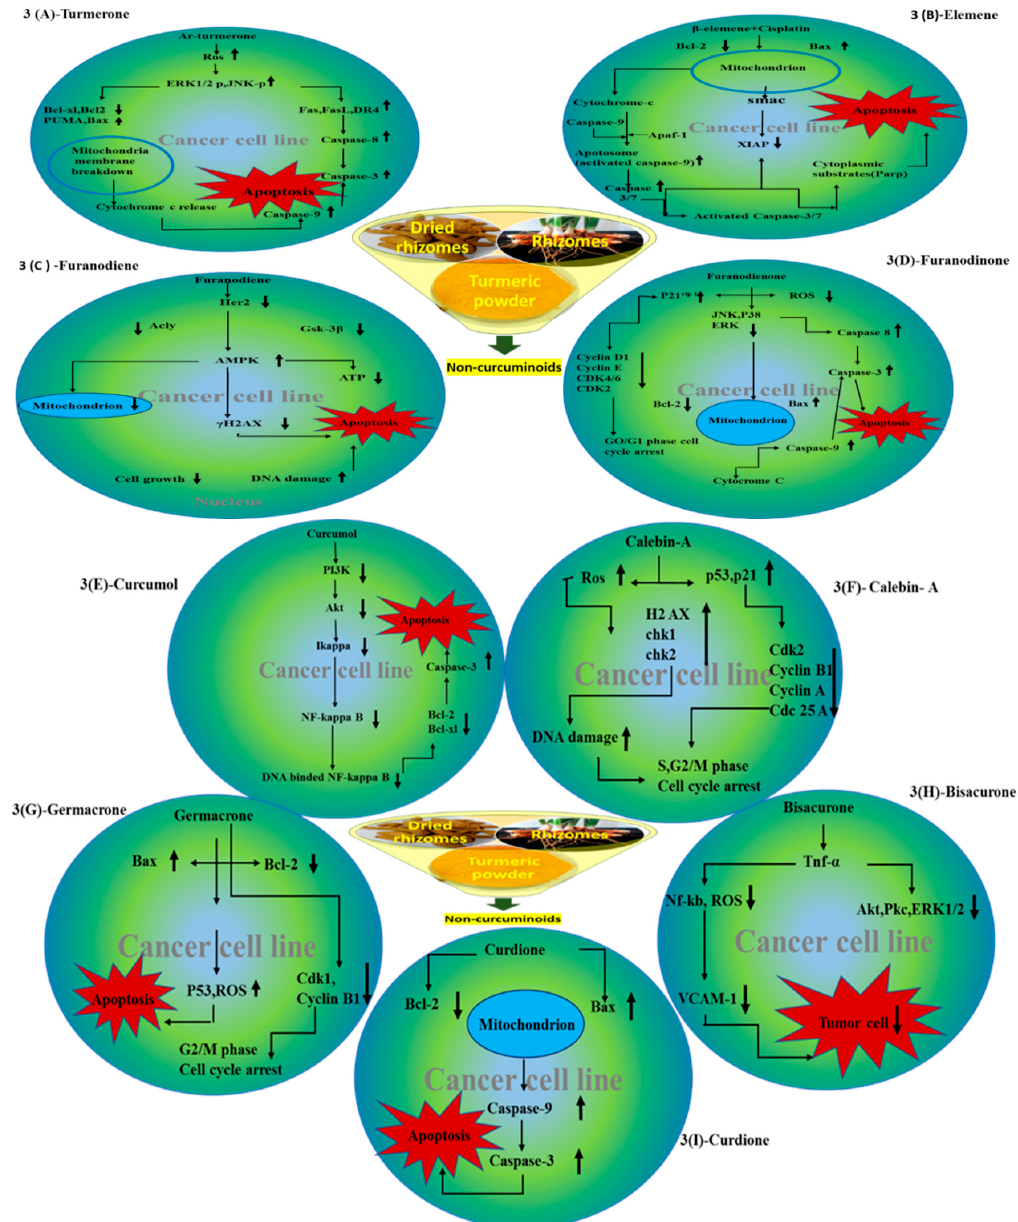
Figure 3. Mechanism of action of various non-curcuminoids anticancer pathways: ( A ) Ar-turmerone; ( B ) β -elemene; ( C ) furanodiene; ( D ) furanodinone; ( E ) curcumol; ( F ) calebin A; ( G ) germacrone; ( H )